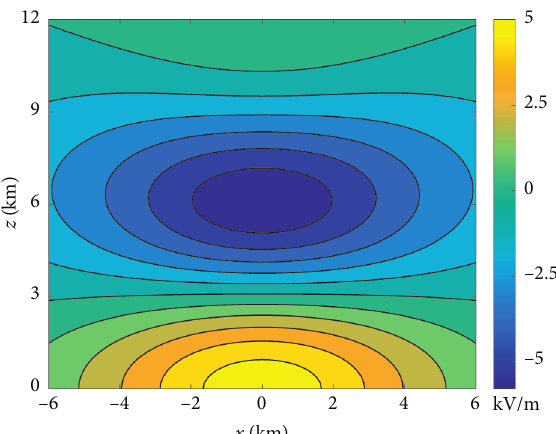
Figure 13: Contour of potential distribution on the longitudinal section while y � 0.